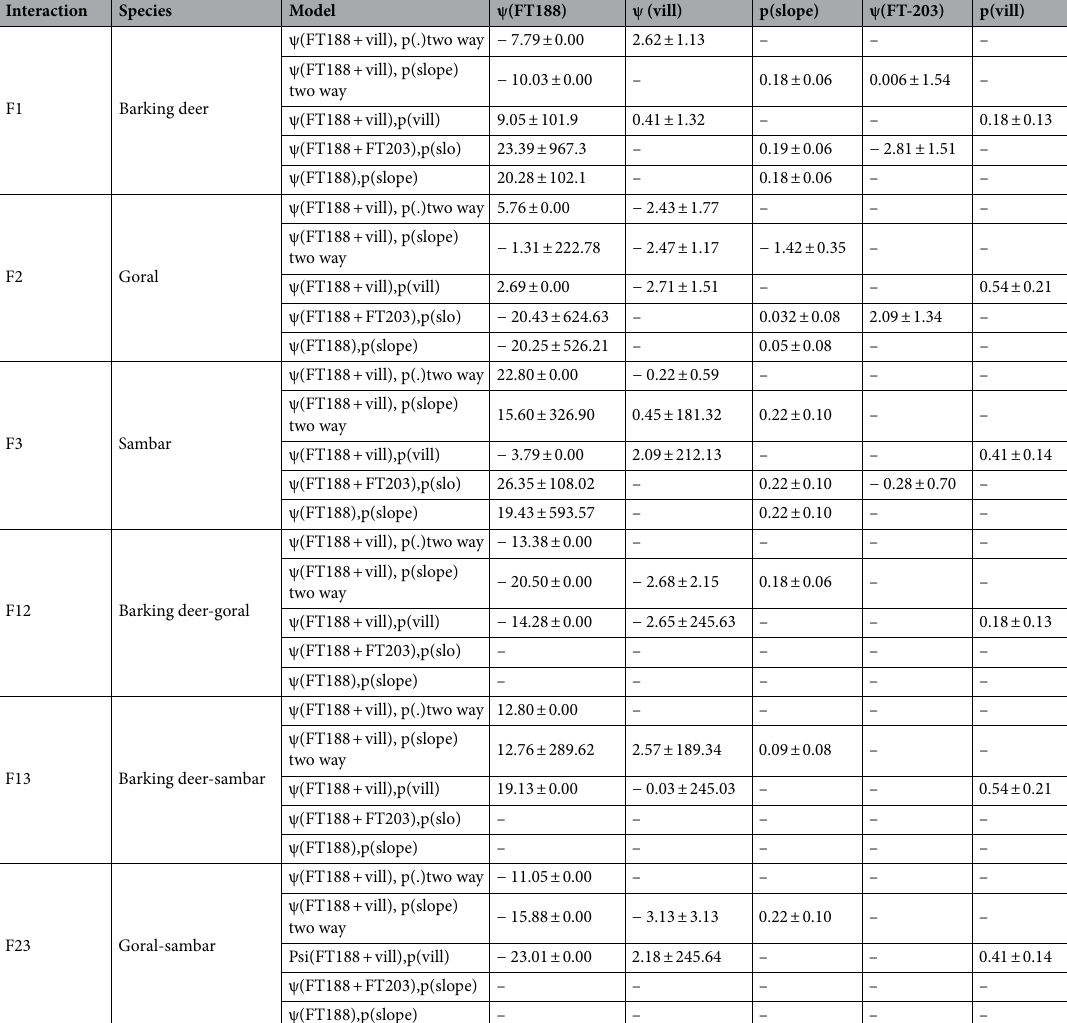
Table 2. Top five models with beta values showing influence of different site covariates, species specific interaction and pair-wise interaction on occupancy and detectability of three ungulate species.